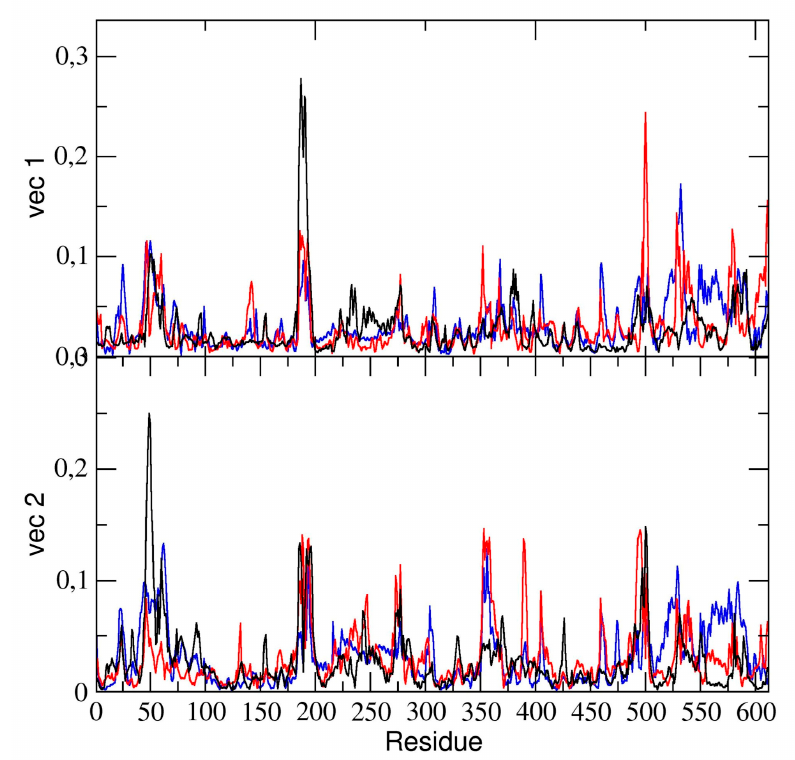
Figure 6. Absolute components of the first two C- α eigenvectors for the dimeric 3CLpro for runs #1 (black line), #2 (blue line), and #3 (red line).